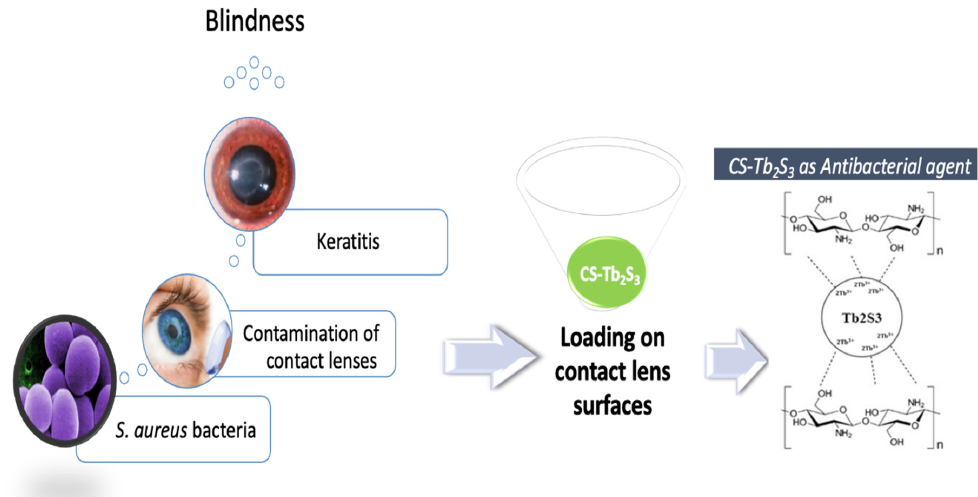
Figure 8. Illustration of contamination of the S. aureus bacteria onto contact lenses and treatment using CS-Tb 2 S 3 nanocomposites coated onto contact lens